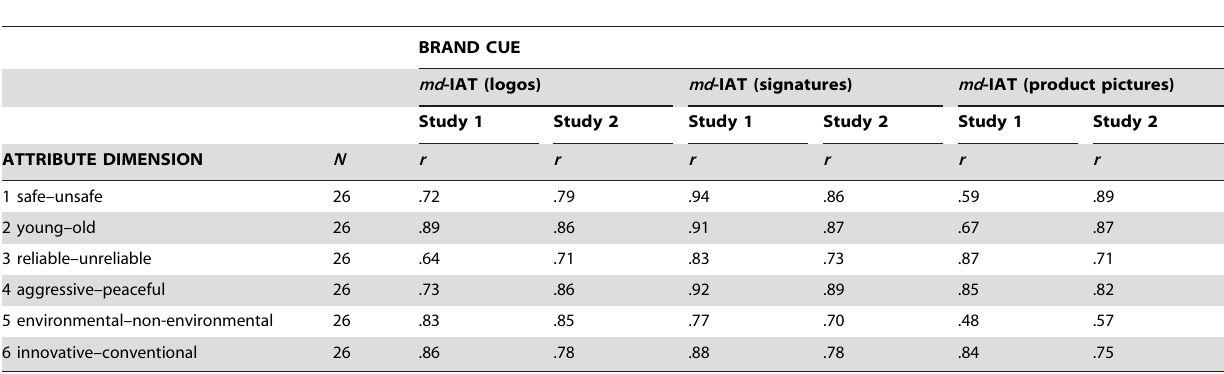
Table 4. Split-half estimates of reliability for each of the 6 6 3 IATs in Study 1 and Study 2.